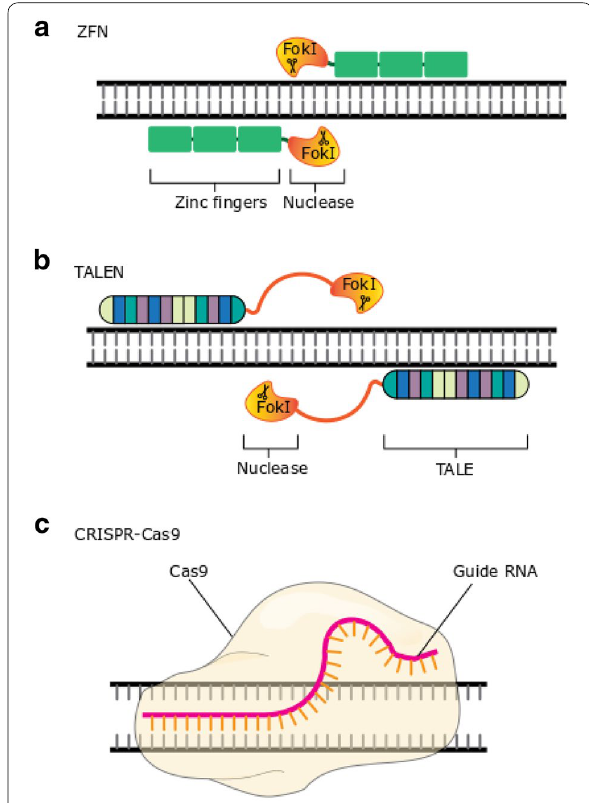
Fig. 1 Gene editing technologies used in cell therapies. Depicted are the three basic structures and main characteristics of each